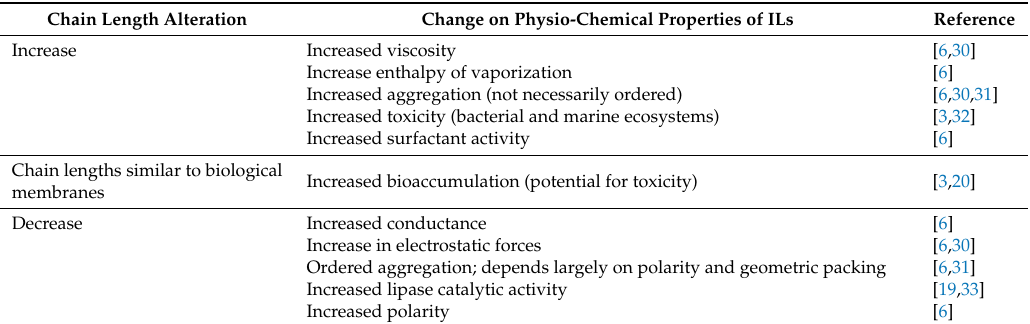
Singular change to cation chain length leading to altered physicochemical